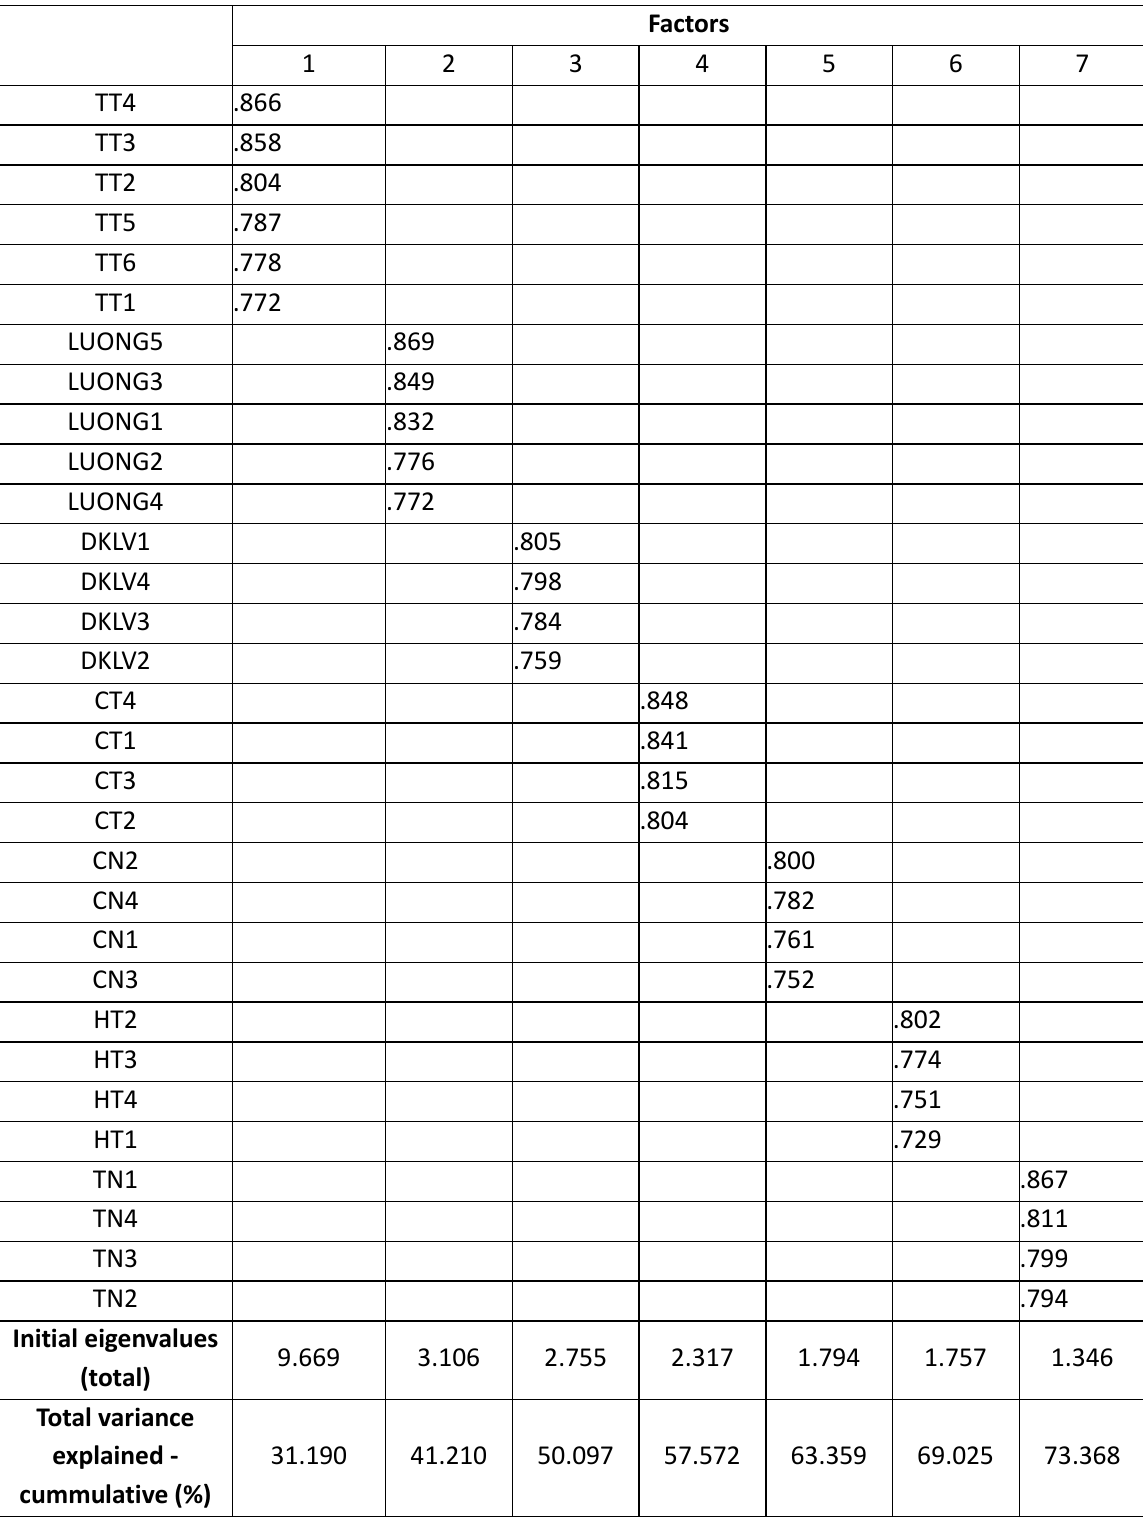
Table 3. Factor rotation matrix result of independent